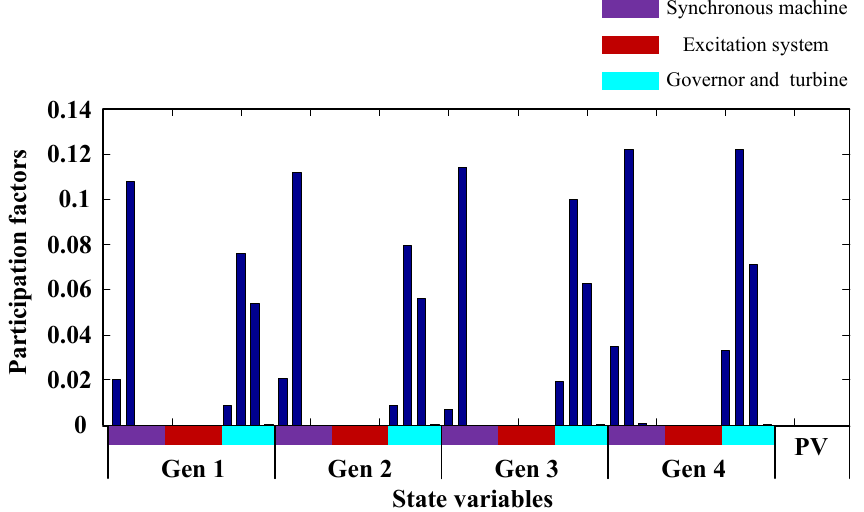
Figure 9. Participation factors. The state variables of synchronous machines contain δ , ω , E ’ d , and E ’ q .